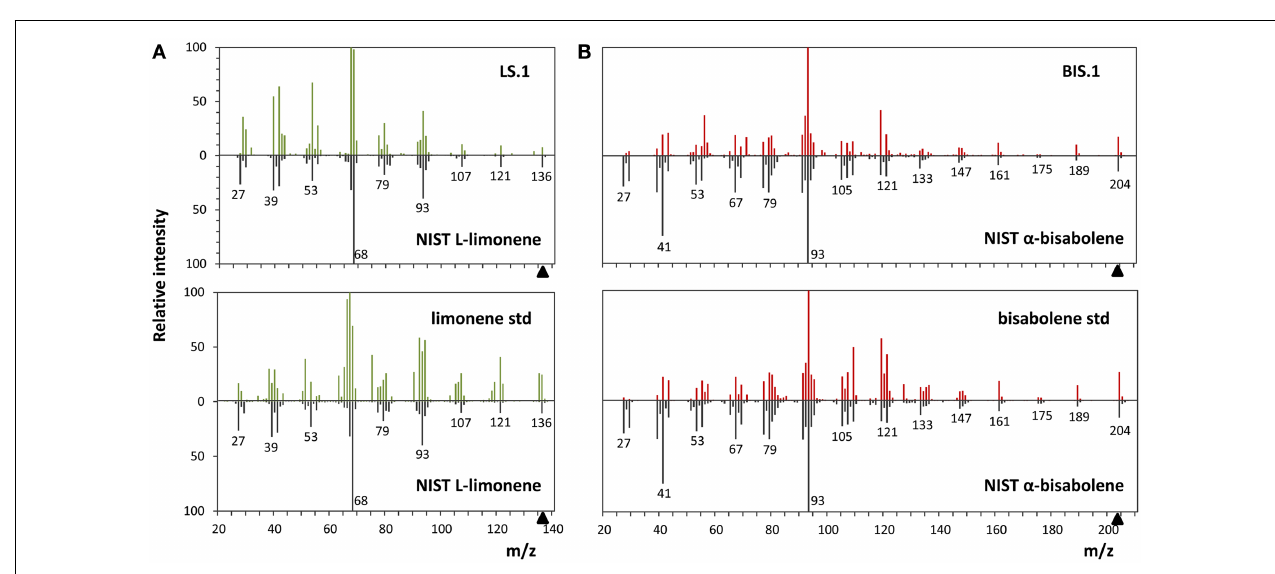
and the authentic L -limonene standard (lower panel). (B) α -Bisabolene NIST reference spectra alignment with the putative α -bisabolene peak in the BIS.1 line (upper panel) and a commercial bisabolene standard (lower panel).